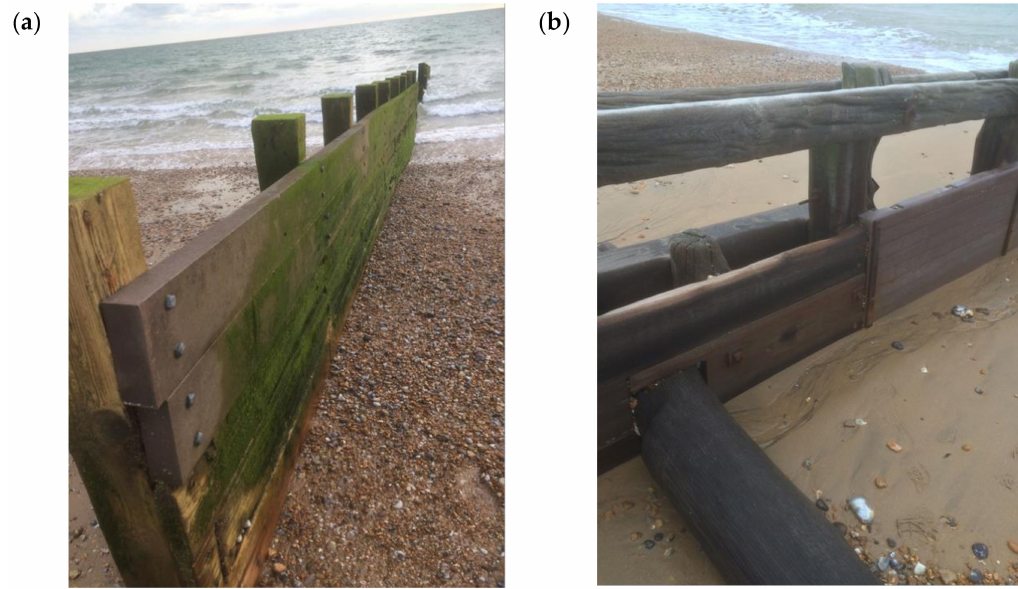
Figure 8. ( a ) Successfully repaired groyne with the re-formative polymer, and ( b ) evidence after 12 years of less wear and erosion on the re-formative polymer compared to the greenheart tropical hardwood